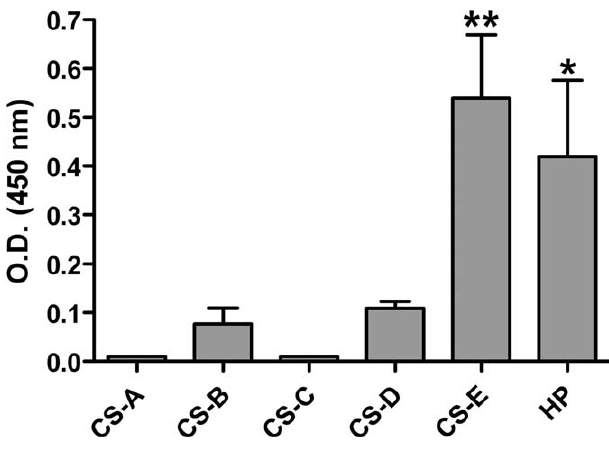
Figure 5. Direct Binding of DENV NS1 with HS and CS-E Microtiter plates were coated with indicated soluble GAG overnight at 4 8 C. After incubation with supernatants from BHK-DENV-2-Rep cells or control BHK cells, bound DENV NS1 was detected using DENV NS1– specific mAbs, followed by biotin-conjugated anti-mouse IgG and HRP- conjugated streptavidin. Plates were read at an optical density of 450 nm on a 96-well plate reader. Data are the mean 6 SD from four independent experiments. Asterisks denote NS1 binding that is statisti- cally different from binding to background (* p , 0.05, ** p , 0.005). O. D., optical density.